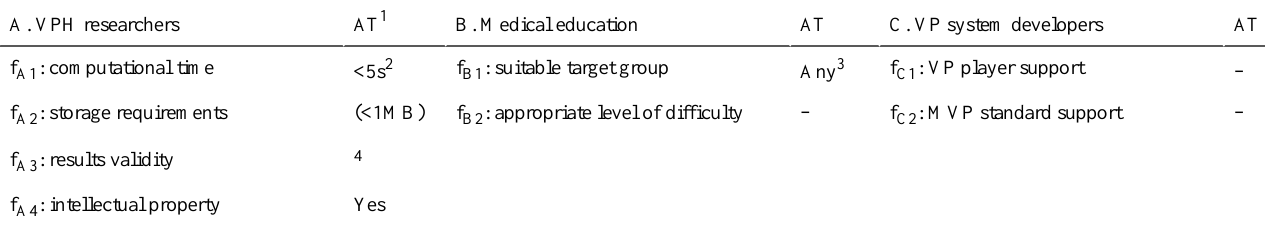
Table 3. VPH ARCH evaluation profile—selected feasibility factors and